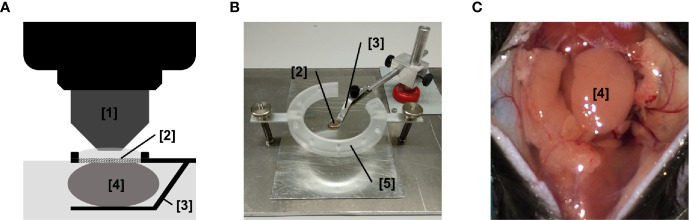
Experimental setup for in vivo microscopy analyses of the submandibular gland microvasculature. (A) Schematic illustration of the microscopy setup for in vivo analysis of the microcirculation in the mouse submandibular gland. (B) Representative image of the microscopy stage for in vivo imaging of the microcirculation in the mouse submandibular gland. (C) Representative image of the operation situs of the anterior neck region after careful dissection of the submandibular gland. ([1] dipping objective; [2] glass-window for microscopy; [3] mounting of stage; [4] submandibular gland (synonyms in veterinary anatomy: mandibular gland or submaxillary gland); [5] fixation ring for skin sutures; n.s., non significant.